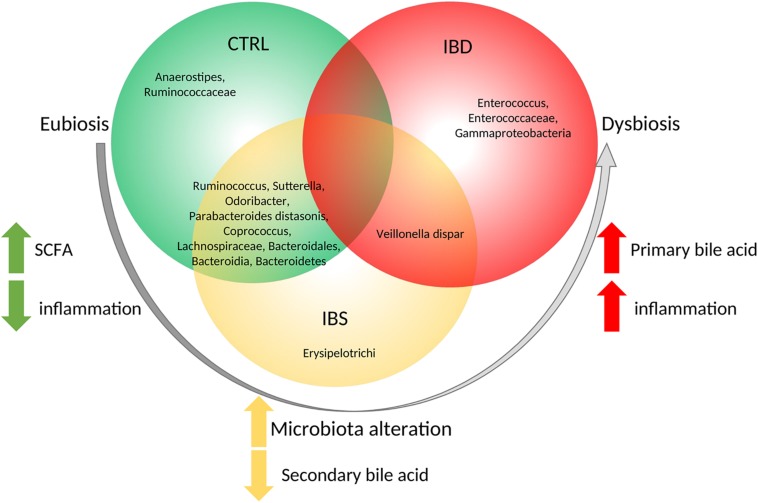
Descriptive model of microbiota composition and its role starting from eubiosis to dysbiosis based on biopsy samples. Model suggests that, in eubiosis condition, specific OTUs compose microbiota and maintain equilibrium. A microbiota alteration trigs the inflammation, leading to an increment of Erysipelotrichi and a reduction of secondary bile acid production. Then a further increment of inflammation leads to increase of primary bile producers with the consequence of dysbiosis.